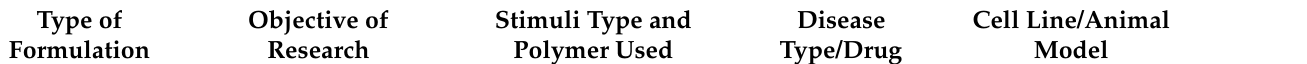
Table 5. Ion-responsive systems for vaginal drug